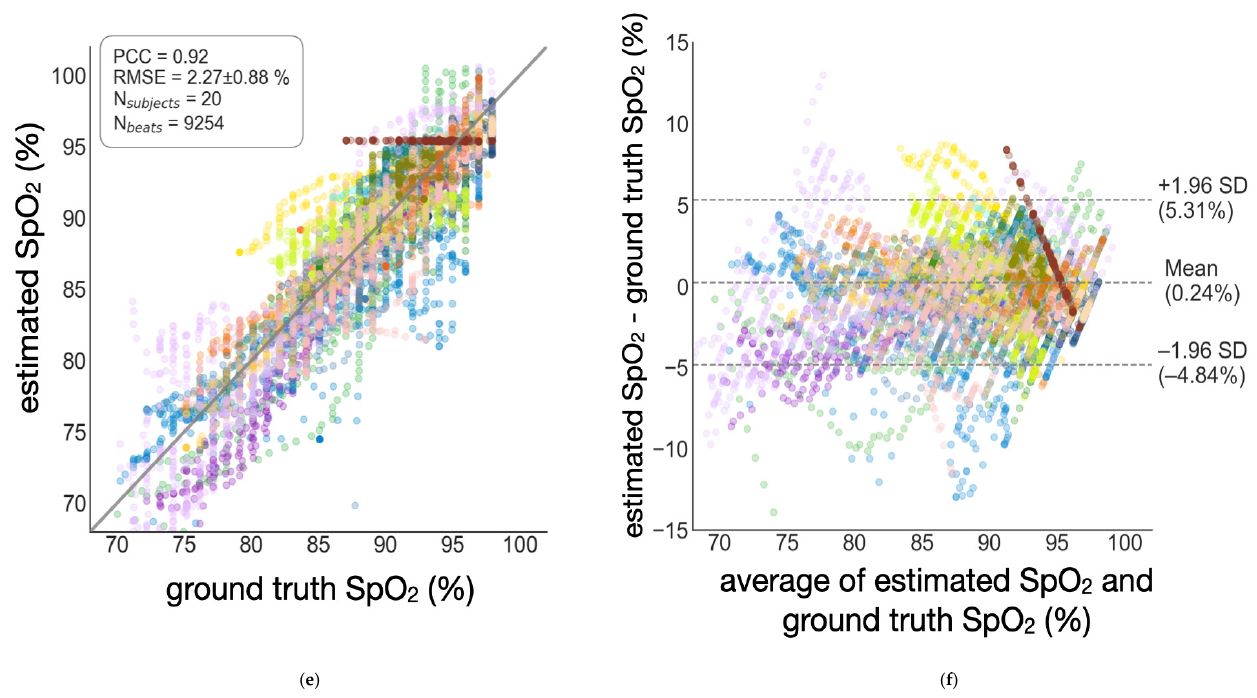
Figure 6. Estimation performance of the wearable patch biosensor. The root-mean-square error (RMSE) across subjects and Pearson correlation coefficient (PCC) are shown. Note each color represents a subject. ( a ) Regression analysis of the globalized scheme. ( b ) Bland–Altman analysis of the globalized scheme. ( c ) Regression analysis of the semi-globalized scheme. ( d ) Bland–Altman analysis of the semi-globalized scheme. ( e ) Regression analysis of the subject-specific scheme. ( f ) Bland–Altman analysis of the subject-specific scheme.